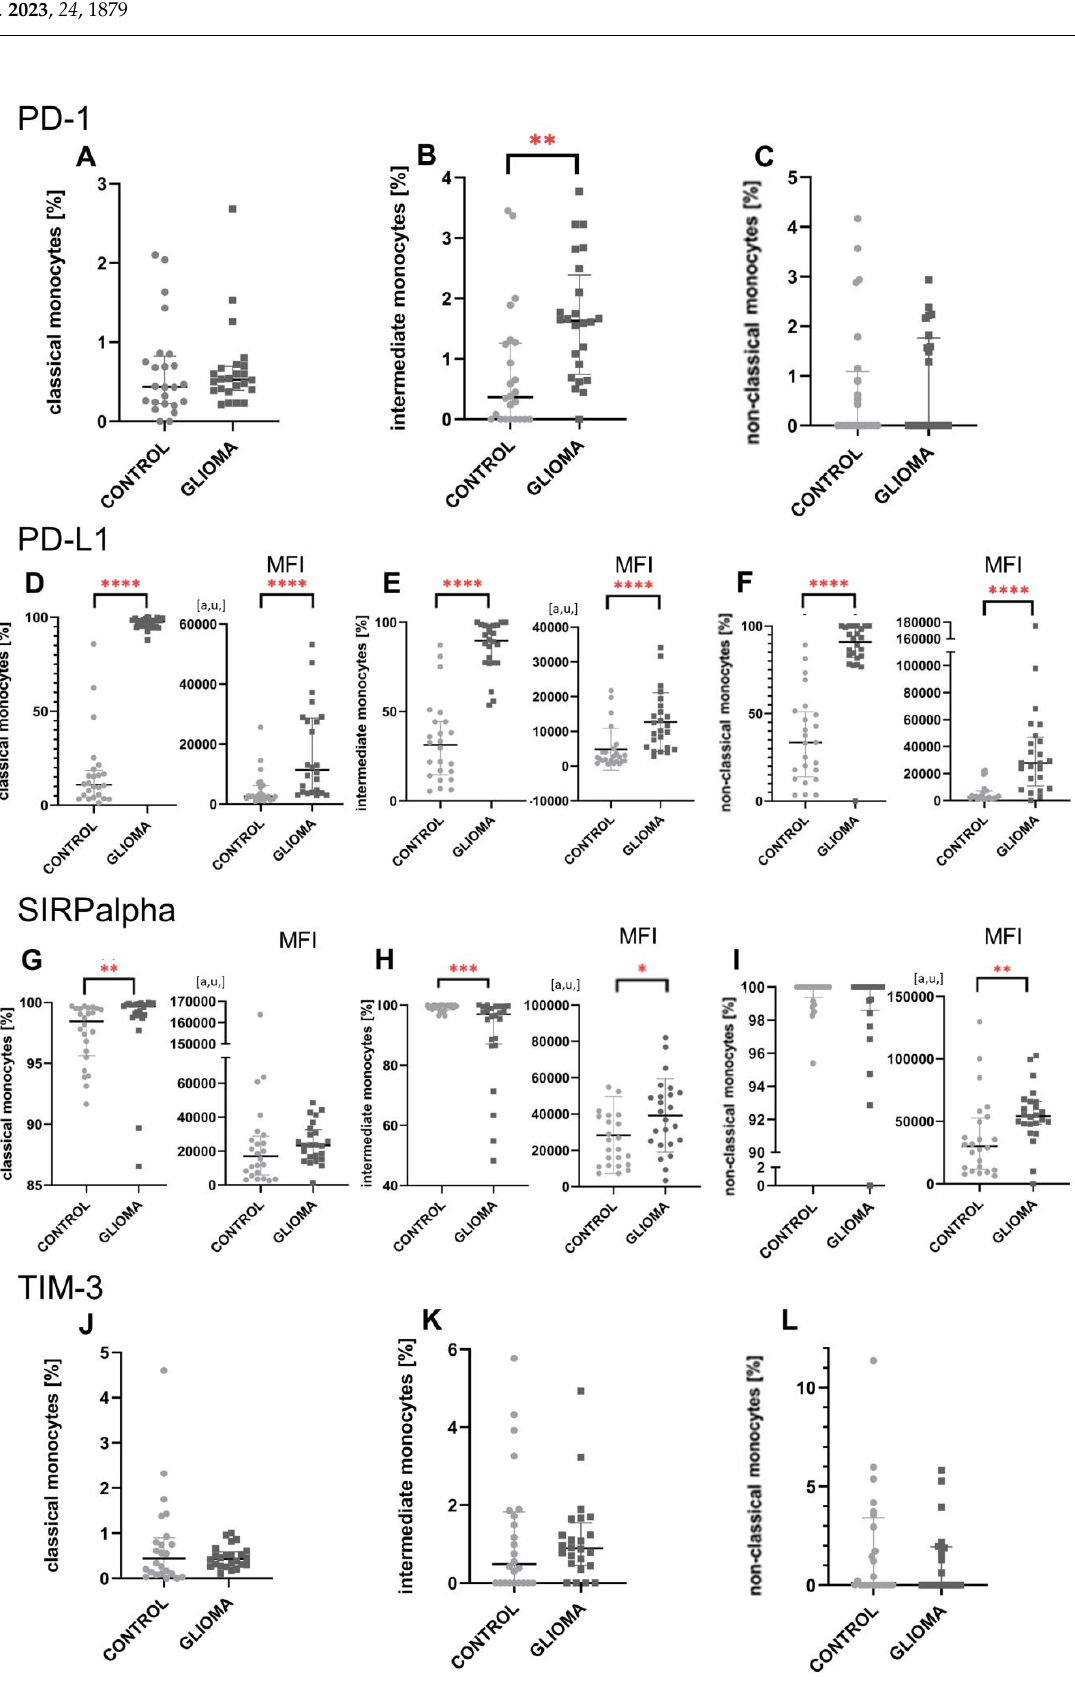
Figure 2. The results for immune checkpoint molecules expression on glioma patients’ monocytes vs. healthy individuals. Percentage of classical ( A ), intermediate ( B ) and non-classical ( C )